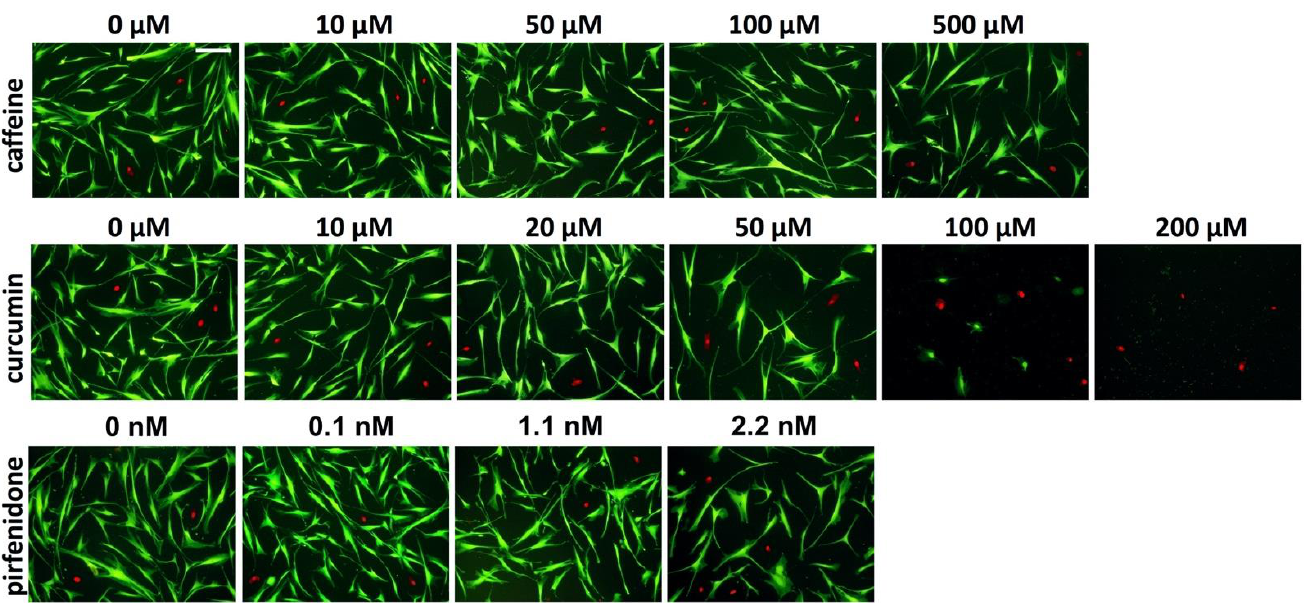
Figure 1. Activated corneal stromal keratocytes (aCSK) incubated in media for 48 h containing the indicated concentrations of the antifibrotic molecules (AFM) caffeine, curcumin and pirfenidone. Green cells are alive, red cells are dead. Scale bar: 200 µm.